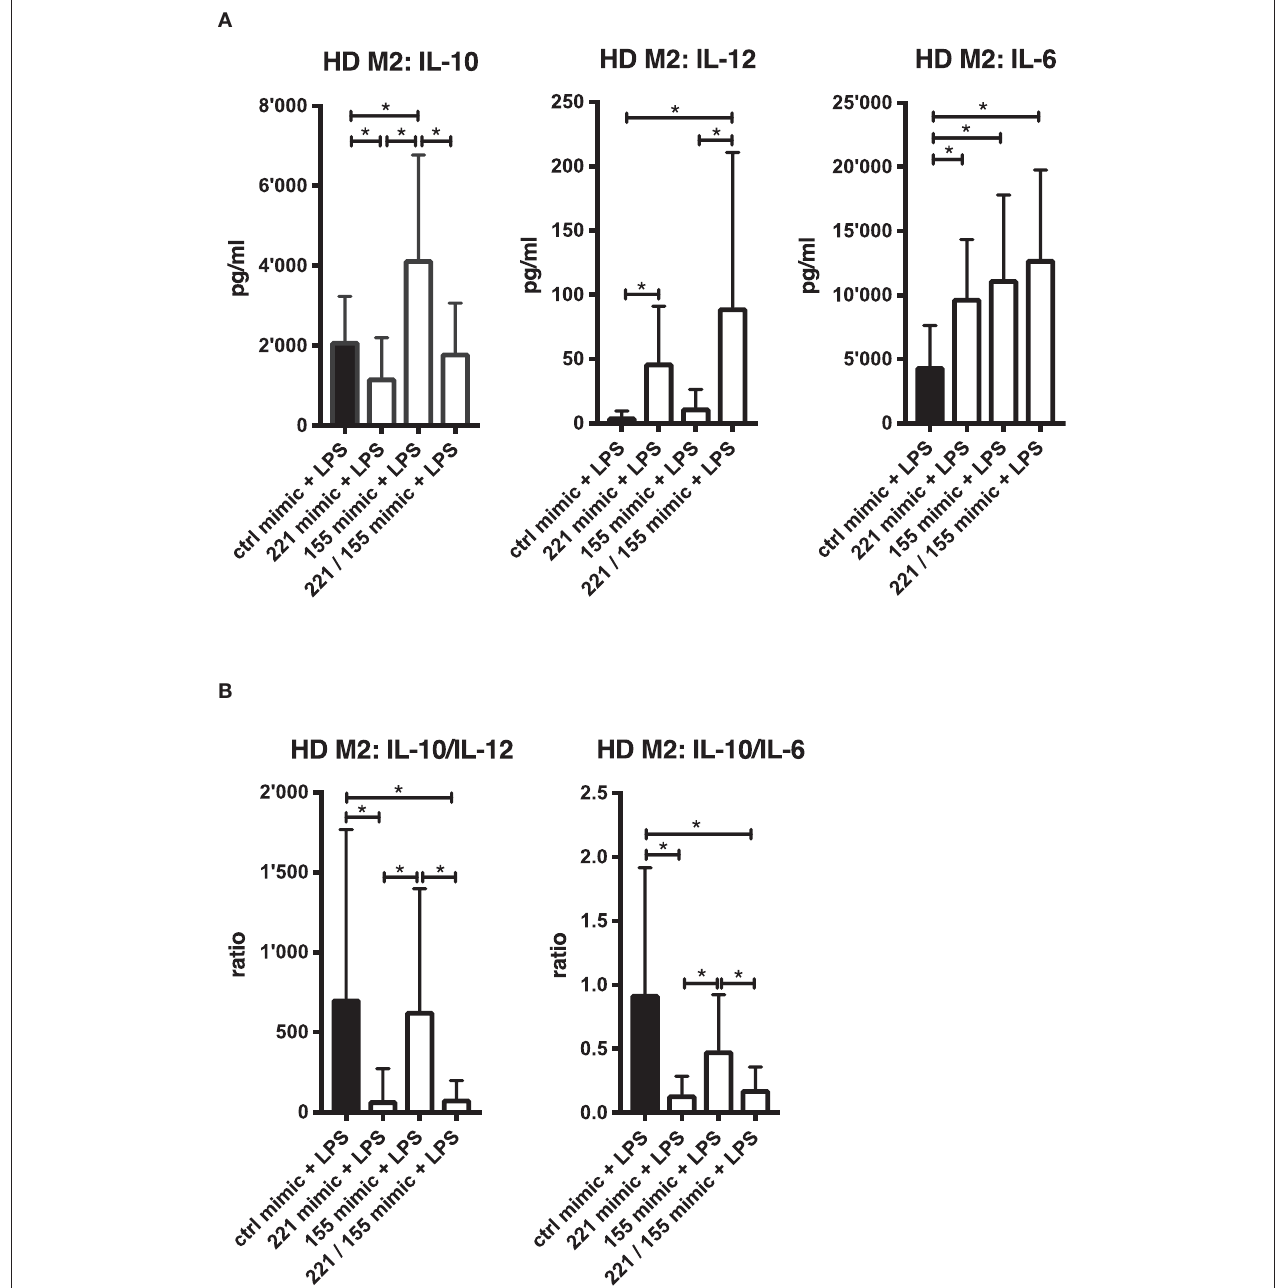
FIGURE 8 | Effects of combined miR-155-5 p /miR-221-3 p mimics on pro- and anti-inflammatory cytokine secretion in TLR4-stimulated M2-macrophages. Cells were differentiated from CD14 + cells derived from HD blood. (A) M2-macrophages were transfected with mimics of miR-155-5 p and miR-221-3 p , either alone (155 or 221 mimic) or combined (155/221 mimic) and a control miR (ctrl mimic). M2-macrophages were then stimulated with 100ng/ml LPS or left untreated. Secreted cytokines were measured after 24h by ELISA and values are expressed as mean ± S.D. N = 15–18, * p < 0.05. (B) Anti-inflammatory activity of generated M2-macrophages transfected with the mentioned mimic combination setup was calculated after 24h LPS-stimulation by the ratio of secreted cytokines IL-10 to IL-12 or IL-10 to IL-6. Values are expressed as mean ± S.D. N = 15–18, * p <